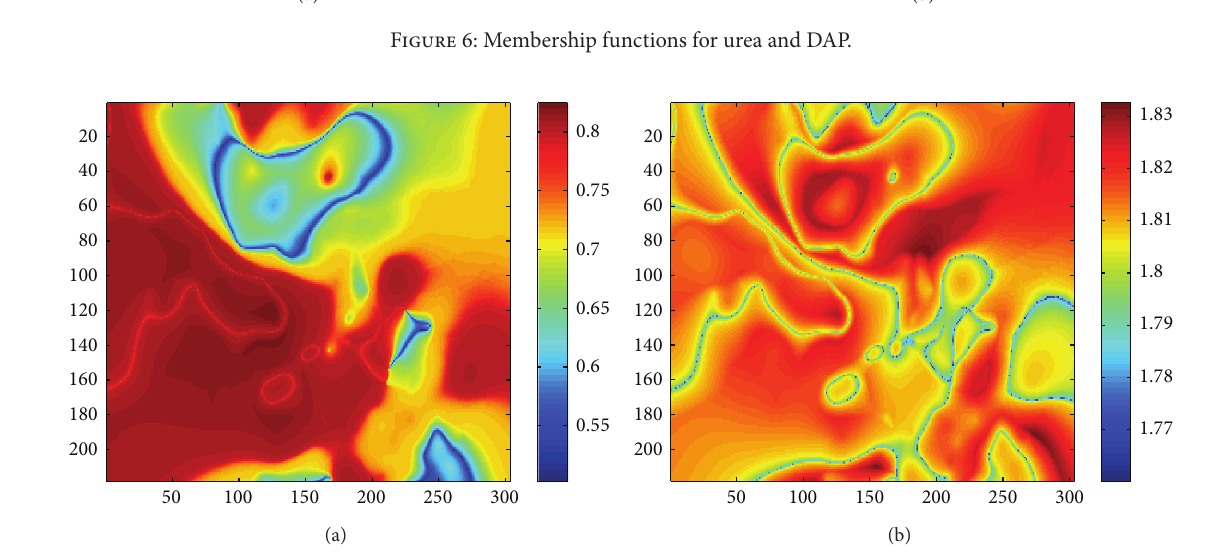
Figure 7: Surfaces of urea and